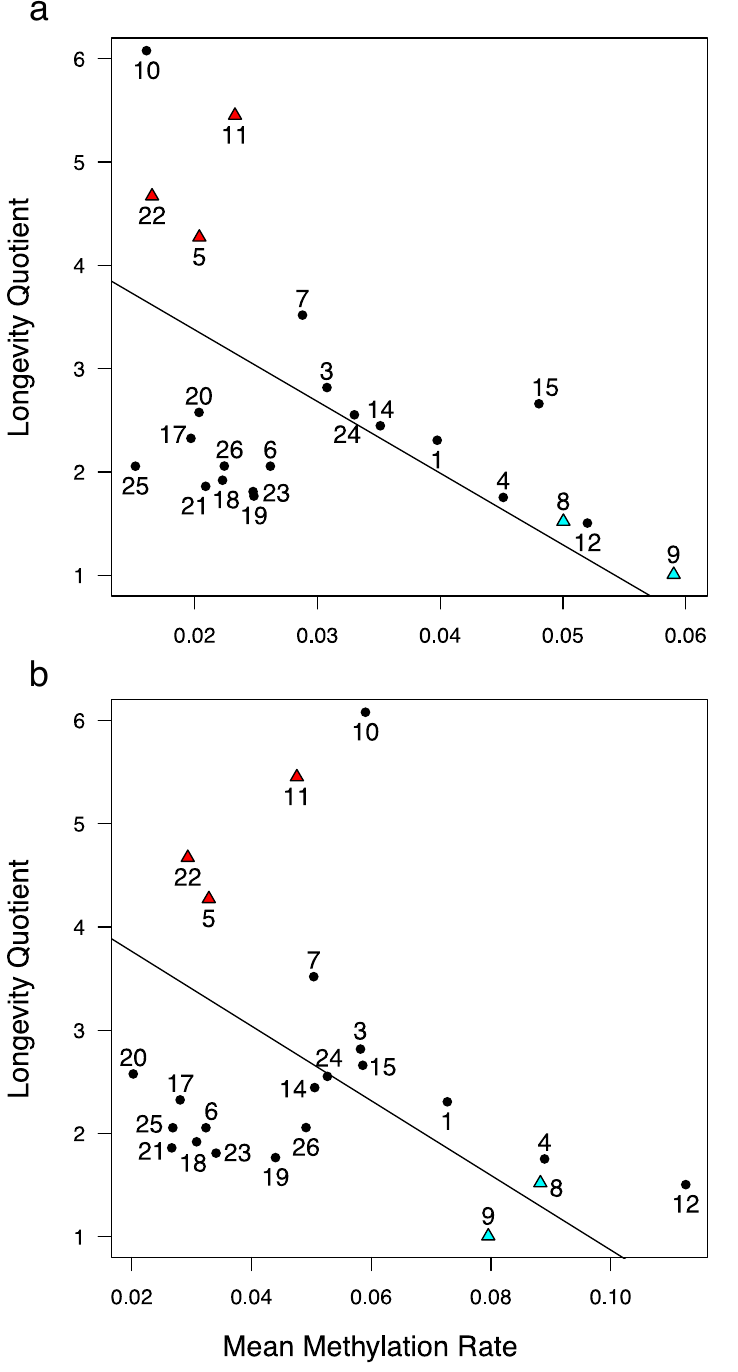
Fig. 2 Species longevity is predicted by the mean rate of DNAm change. a After controlling for phylogeny using phylogenetic generalized least squares regression, mean DNAm rate at 1165 hypermethylating age DMPs correlate with longevity ( r = − 0.704, t = − 4.95, P = 6.79e − 5), b as does mean DNAm rate at 835 hypomethylating age DMPs ( r = − 0.682, t = − 4.27, P = 3.42e − 4). Species longevity is represented by the longevity quotient (LQ), which is the ratio of the observed species maximum lifespan to the maximum lifespan predicted for a non fl ying placental mammal of the same body mass 29 . For example, the maximum longevity of Myotis lucifugus (10) is over six times longer than expected, while the maximum longevity of Molossus molossus (9) is equal to an average placental mammal of the same body size. The fi ve species used for identifying longevity DMPs by the difference in methylation rate are indicated by red triangles (long-lived) and blue triangles (short-lived). Only species with more than ten samples are Given that regions near promoters contain more age and longevity DMPs in promoter regions show similar patterns of longevity DMPs than expected, we evaluated the genes nearest enrichment among biological process categories, i.e., develop- those DMPs for possible functions. In view of the overlap in age mental process, transcription, and regulation of transcription and longevity DMPs, not surprisingly, genes with age or are enriched in M. molossus (Fig. 4e). Genes with age DMPs in